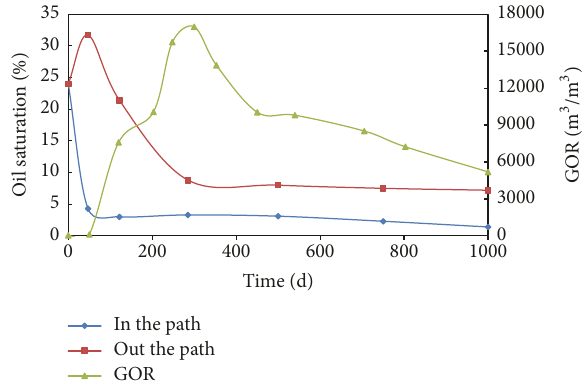
Figure 5: The oil saturation and GOR curves versus CO 2 injection